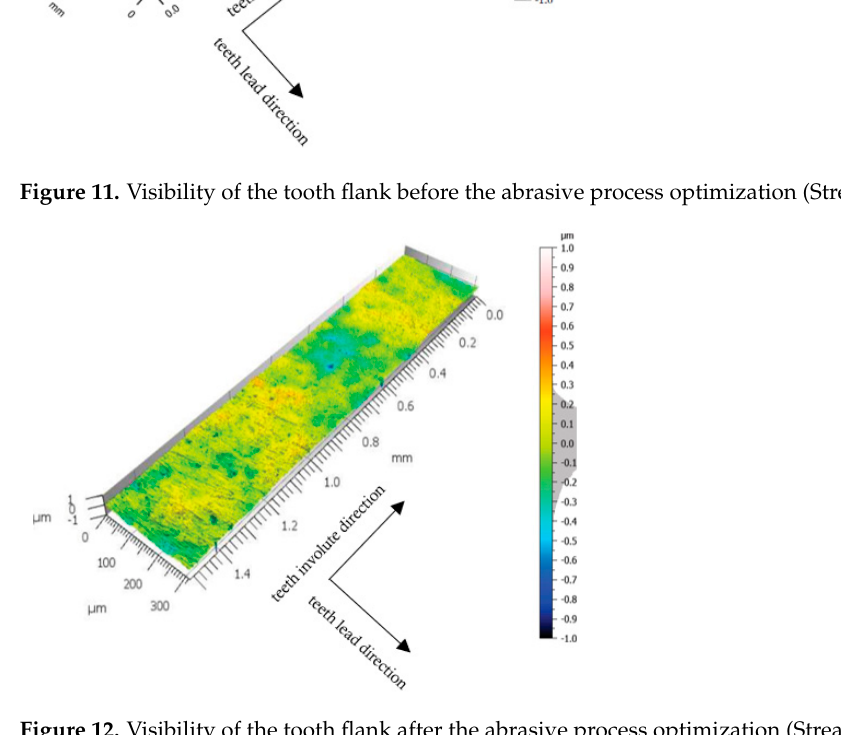
Figure 12. Visibility of the tooth flank after the abrasive process optimization (Stream Finishing).